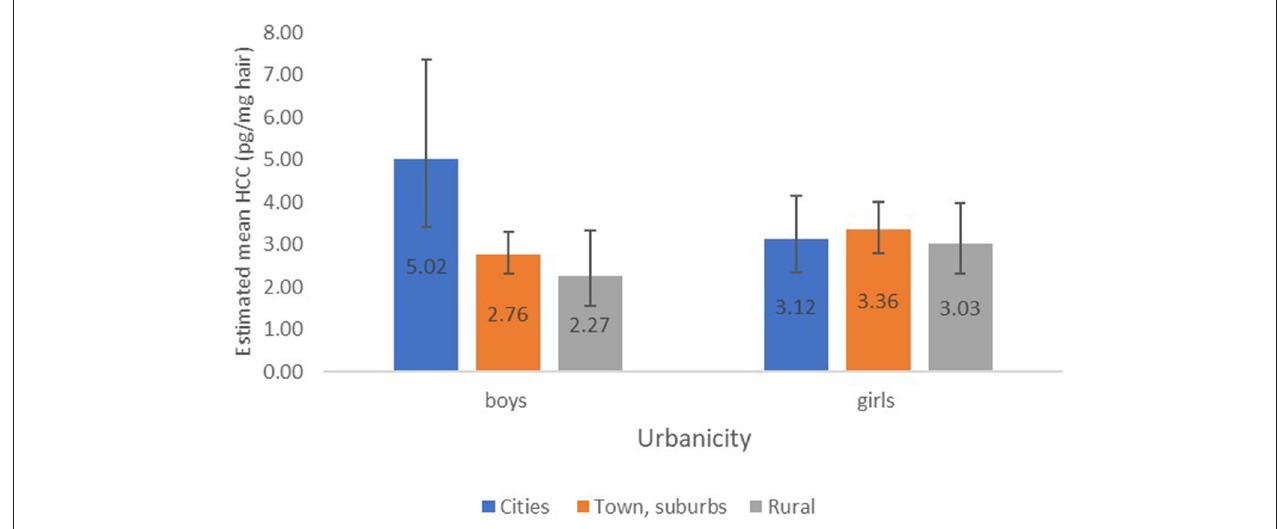
FIGURE 1 | Estimated mean HCC ( ± 95% CI) in relation to urbanicity for boys and girls, associations of HCC with urbanicity adjusted for age, perceived income adequacy, atopic disease and optimal